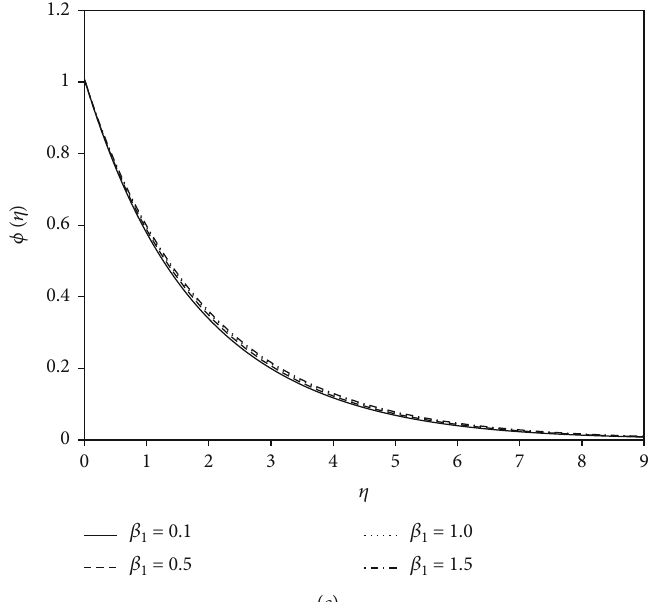
fi le. (b) Di ff erent values of β 1 on the velocity pro